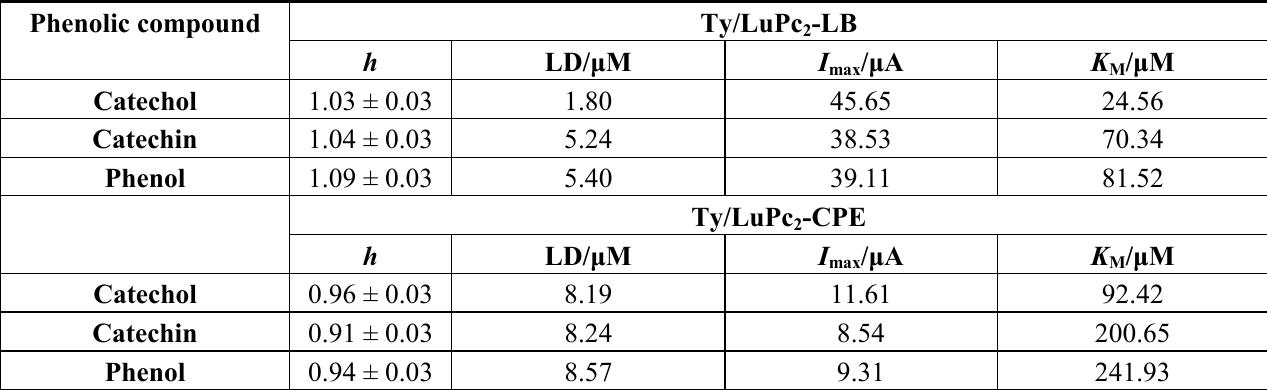
Table 3. Characteristic parameters of the biosensors exposed to phenolic compounds. Phenolic